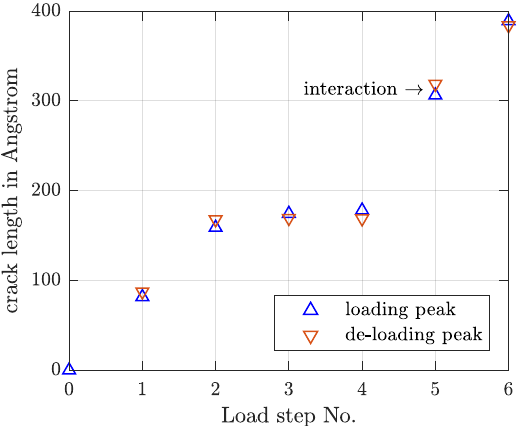
Figure 7. Crack length vs. load step. Low-high block loading.